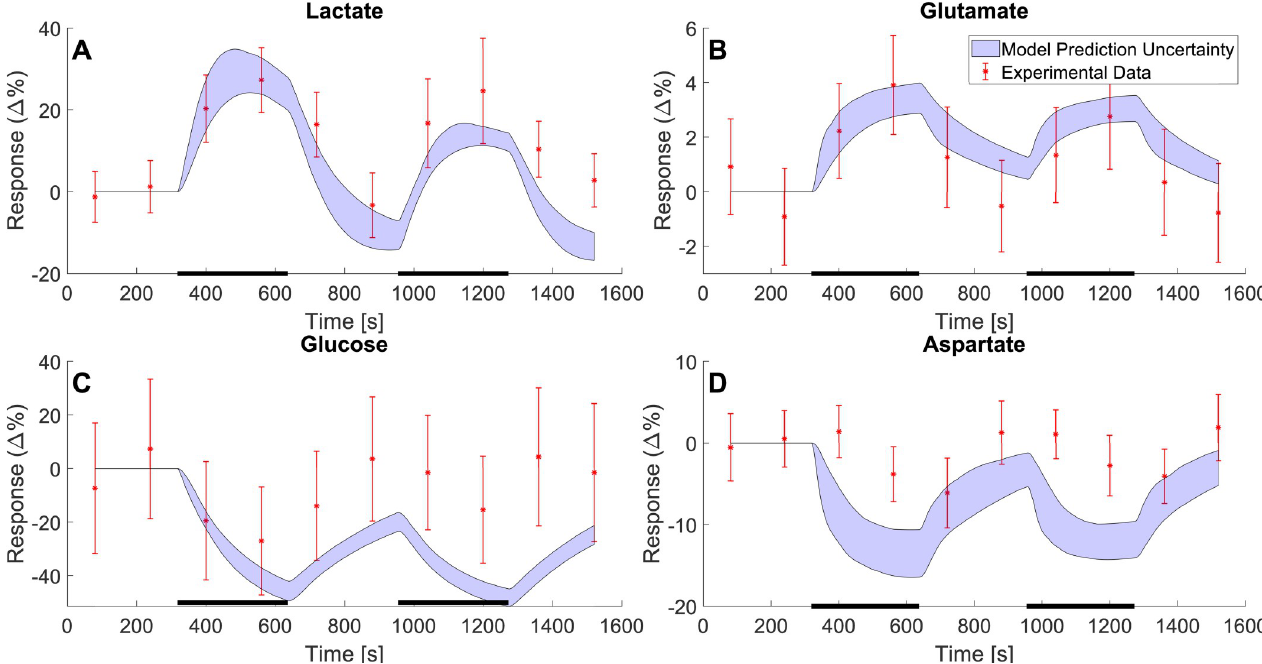
Fig 5. Model predictions compared with independent MRS data for lactate, glutamate, glucose, and aspartate, not used for training the model. The model predictions (blue shaded areas) of the changes in metabolic concentrations for lactate (A), Glutamate (B), Glucose (C), and aspartate (D) as a response to a double stimulation paradigm. The stimulation consisted of two 5.3-minute periods of stimulation (black bars) interwoven by a 5.3-minute rest period. The data is illustrated as mean values ± SEM (red error bars) and was gathered from Bedna ř ı´k et al. 2015 [35].